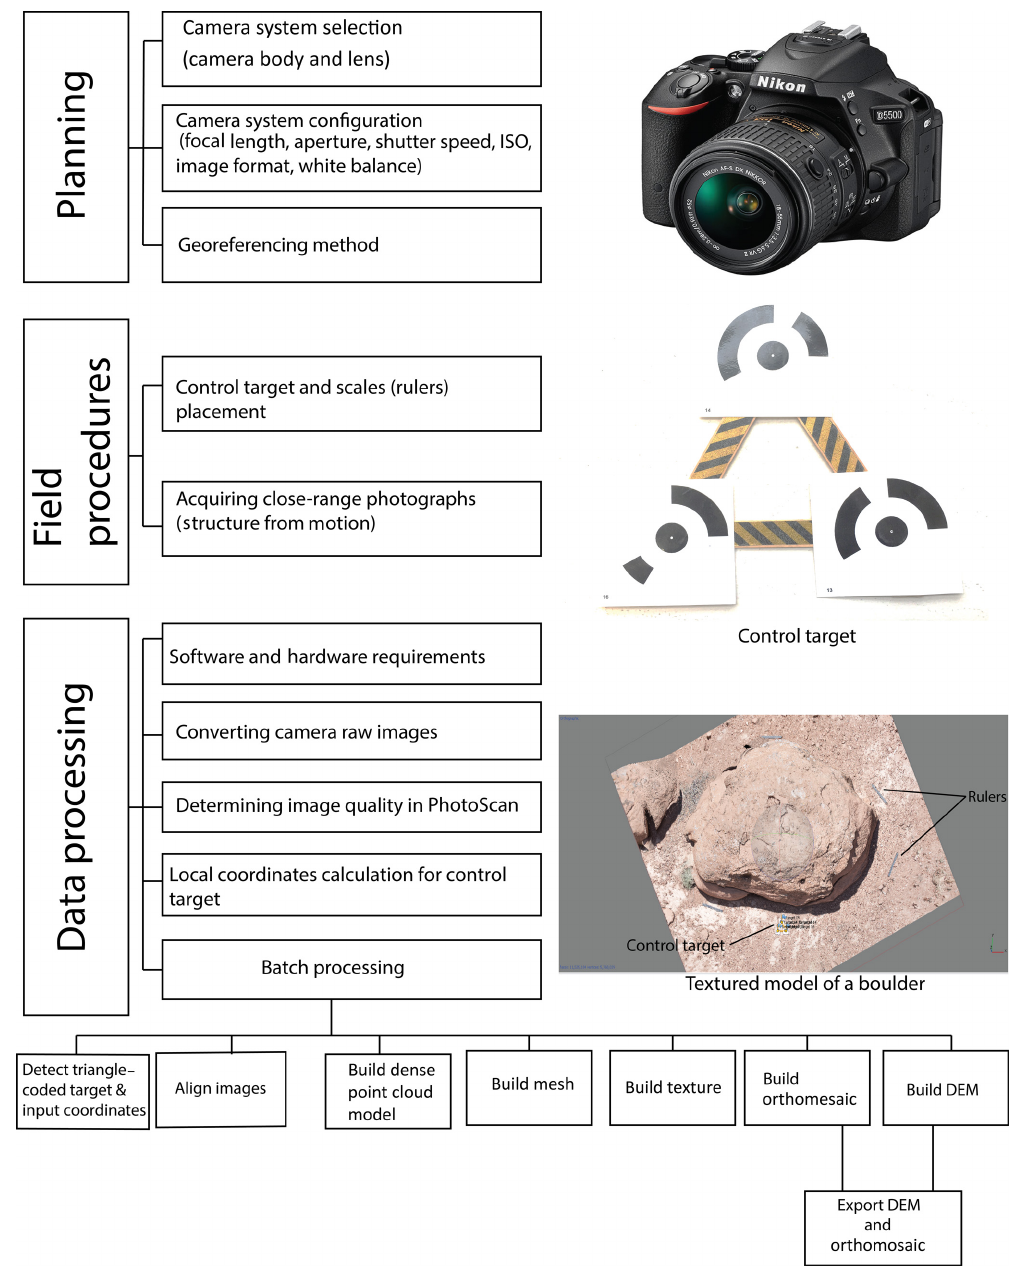
Figure 1. A schematic diagram of the typical workflow for digital elevation model (DEM) production described in this study.